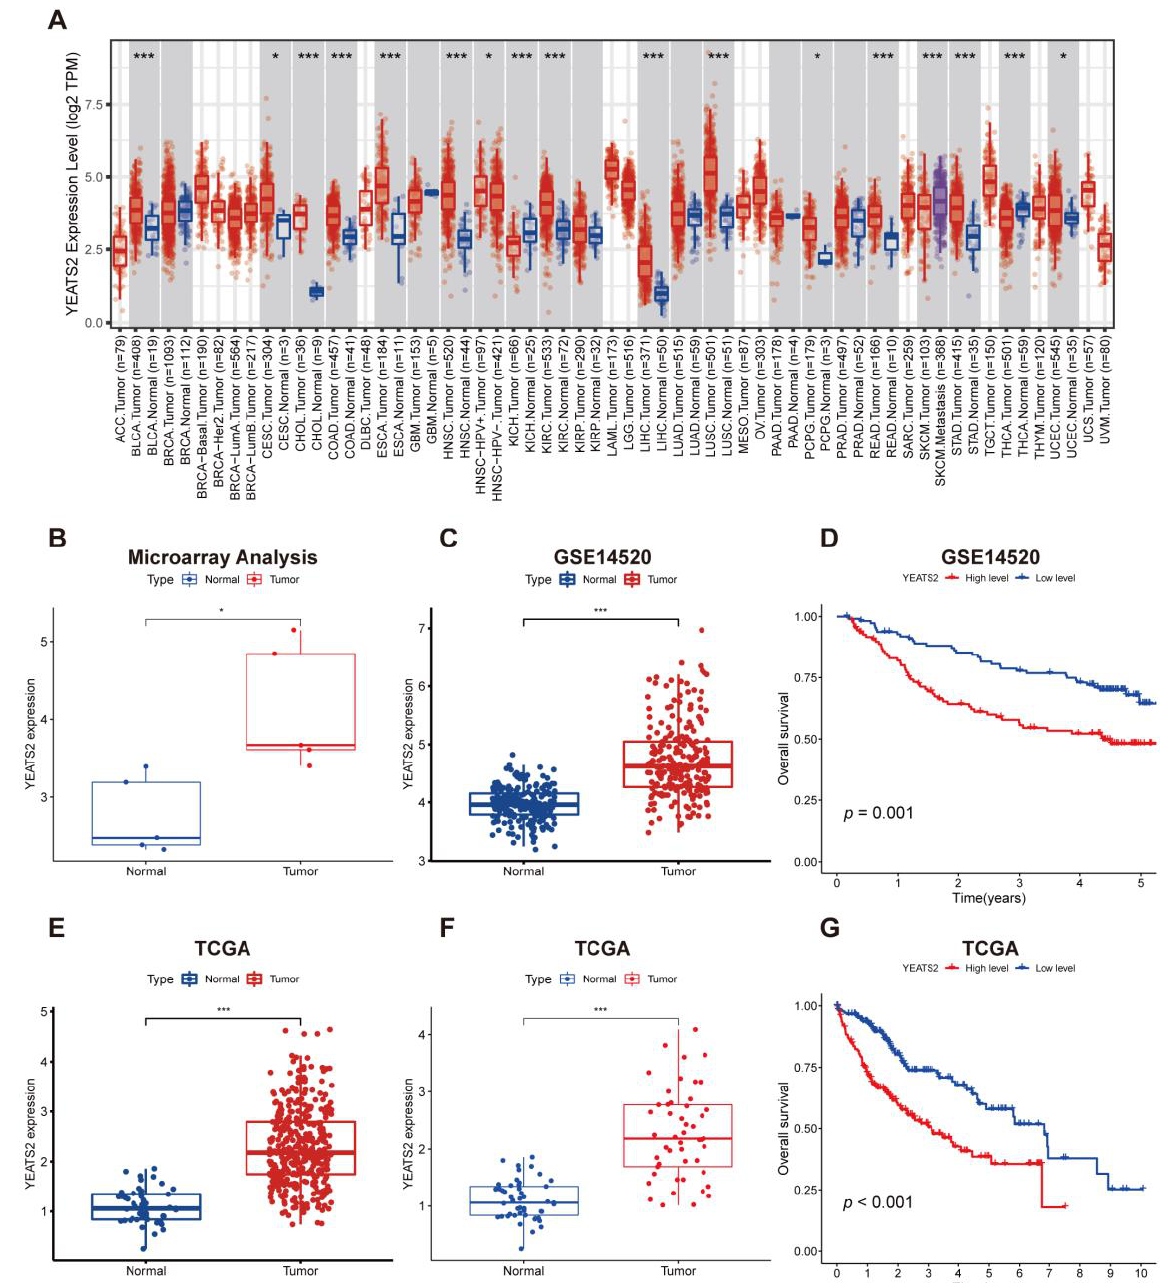
Figure 1. Expression characteristics of YEATS2 in liver cancer samples and its relationship with clinical prognosis. ( A ) Expression of YEATS2 in multiple tumors in the TIMER database. ( B ) Expression of YEATS2 in microarray data analysis of paired samples. ( C ) In the GSE14520 dataset, the expression level of YEATS2 was higher in HCC tissues compared with normal liver tissues. ( D ) Kaplan–Meier analysis was performed on the overall survival (OS) of HCC patients according to the expression of YEATS2 in the GSE14520 dataset. ( E ) YEATS2 expression was identified in 373 tumors and 49 normal samples from TCGA. ( F ) Expression of YEATS2 in paired samples from TCGA. ( G ) Kaplan–Meier analysis was performed on the overall survival (OS) of HCC patients according to the expression of YEATS2 in the TCGA dataset. Data are presented as median and interquartile ranges. * p < 0.05, *** p < 0.001.